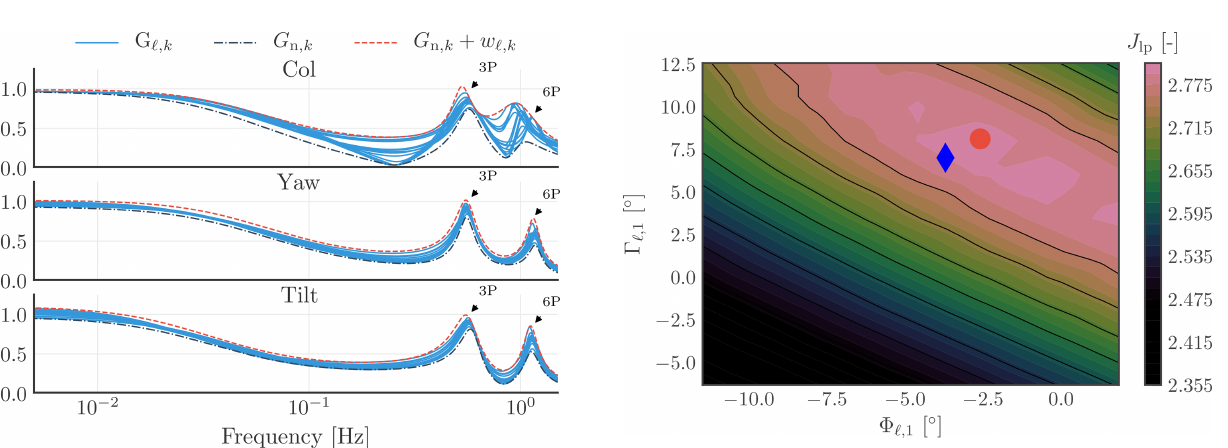
Figure 15. The identified disturbance measurement transfer func- tions ( G (cid:96),k ( jω )) for a discrete set of sampled telescope parameters. The dashed–dotted lines indicate the estimated nominal disturbance measurement models ( G n ,k ( jω )). The dashed lines show the sum of the estimated nominal disturbance measurement models and un- certainty weights ( G n ,k ( jω ) + w (cid:96),k ( jω )), where k ∈ { col, yaw, tilt } .